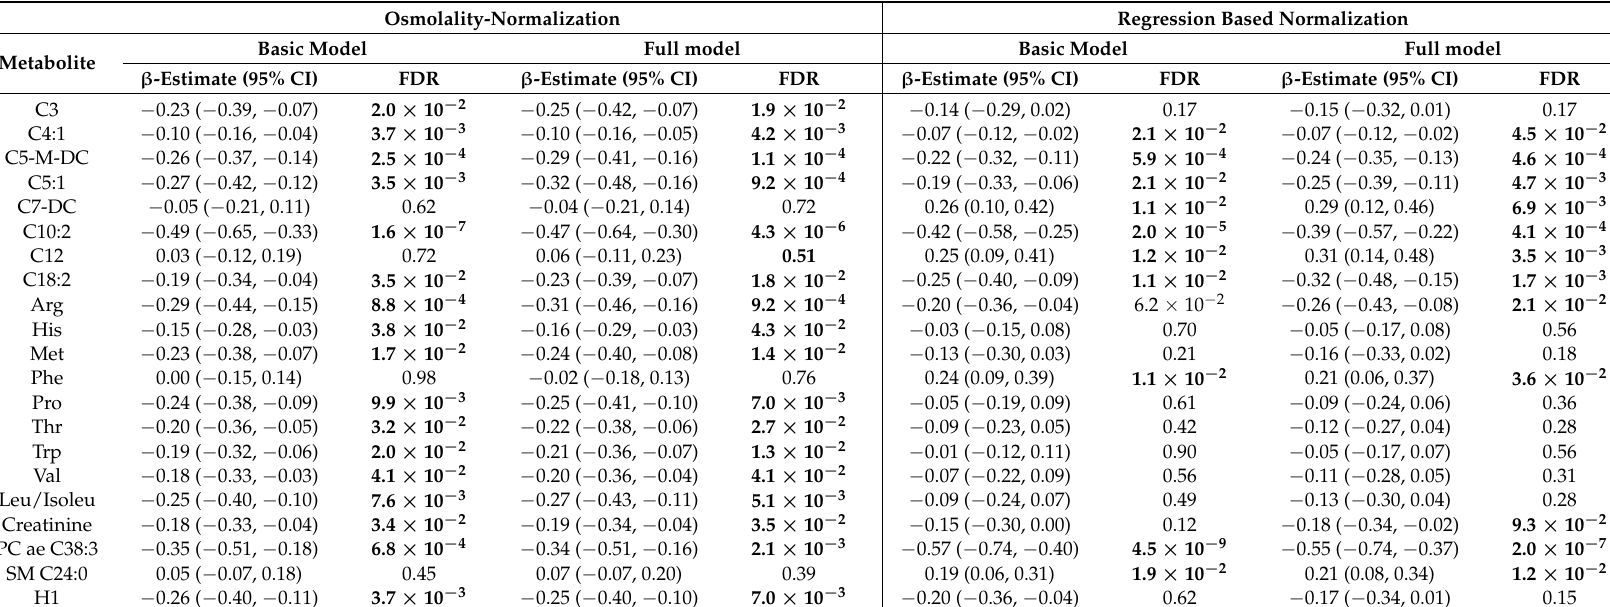
Table 4. Metabolites associated with night shift (osmolality- and regression-based normalized values). The table shows β -estimates and false discovery rate (FDR) values for 21 metabolites which are significantly associated with night shift work. The calculations were based on osmolality and regression-based normalizations. The basic LMEM was adjusted for chronotype value and batch effect. The full model was adjusted for chronotype value, batch effect, BMI, age, smoking status, thyroid disease status, total years of shift work, day of shift and time since last urination. Significant FDR values are indicated in